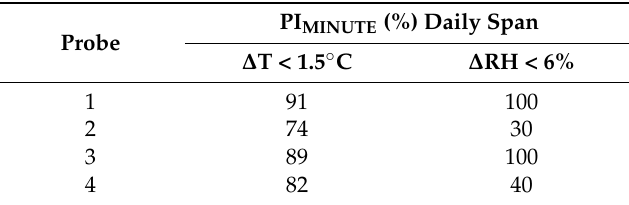
Table 5. Performance Index calculated as the percentage of values of temperature and relative humidity (PI MINUTE(daily span) ) that are inside the limit daily span recommended in the UNI 10829:1999 standard for the conservation of objects made of paper.